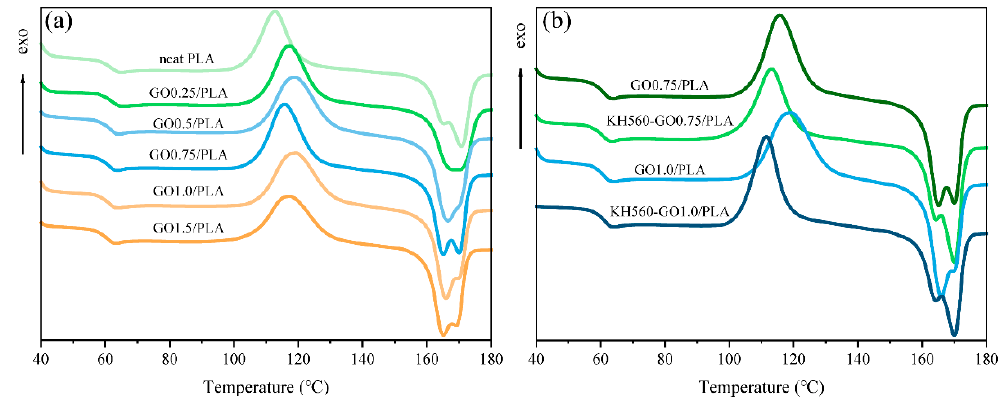
Figure 4. Second heating curves of ( a ) GO/PLA and ( b ) KH560-GO/PLA nanocomposites. Table 1. The list of thermal properties of GO/PLA and KH560-GO/PLA nanocomposites obtained from DSC measurement.